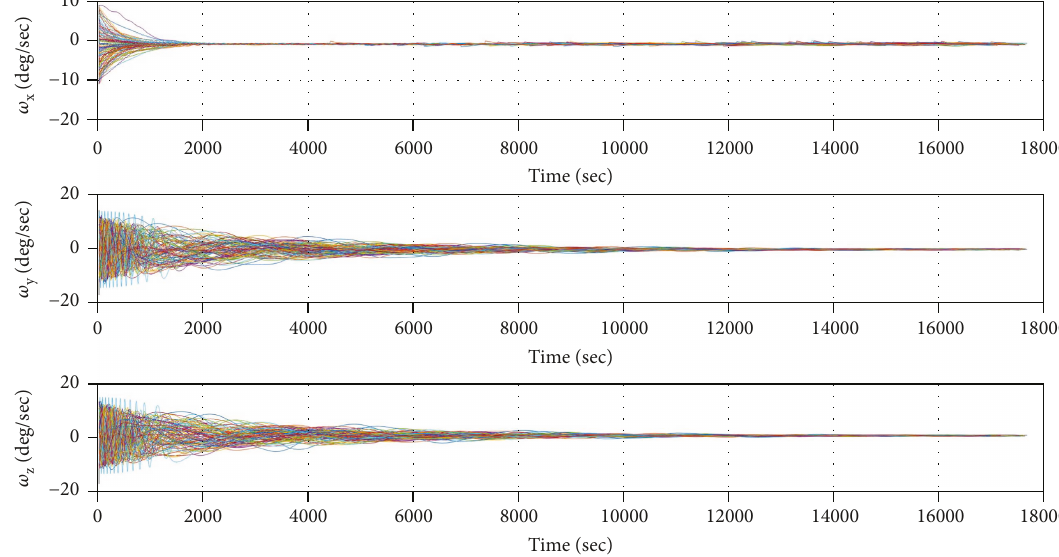
Figure 9: Time behavior of the angular rates ( ω the deployment conditions and on the inertial properties of the